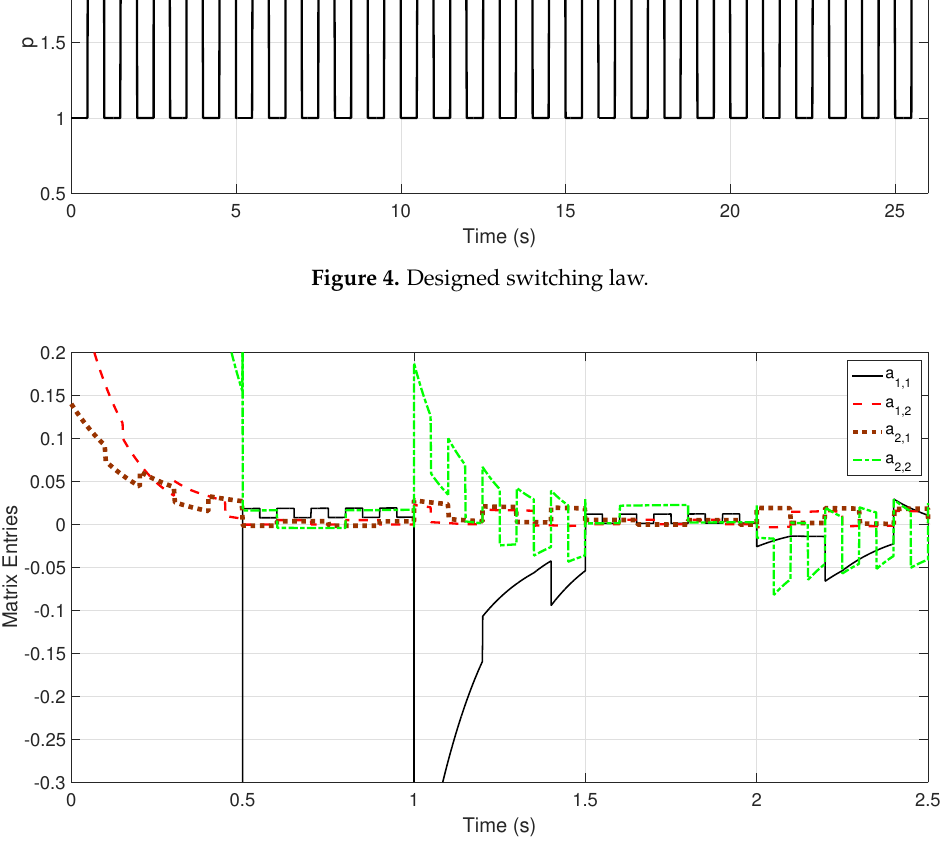
Figure 5. Arbitrary changes in parameters/entries of the system’s matrix.